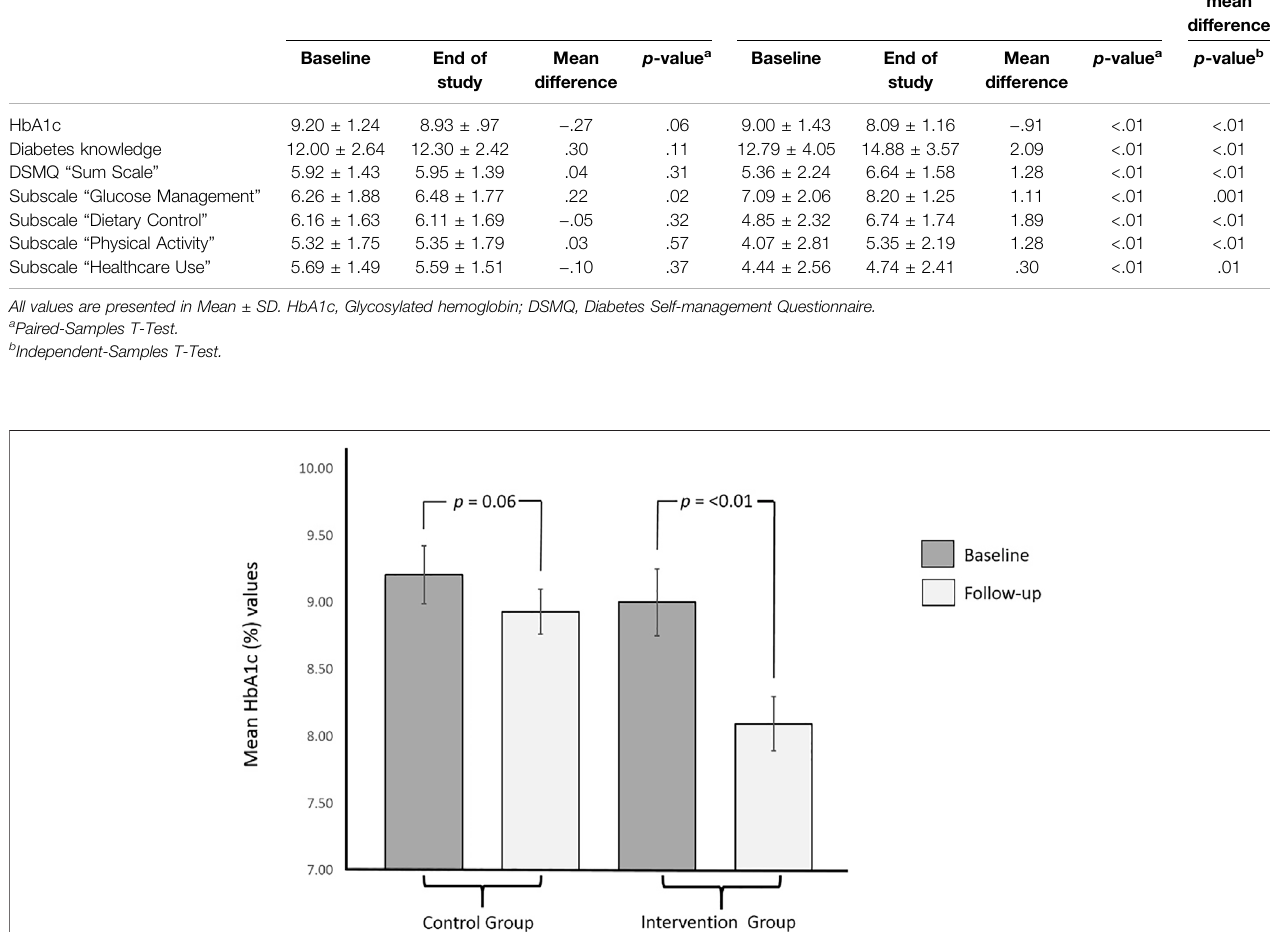
Frontiers in Pharmacology |